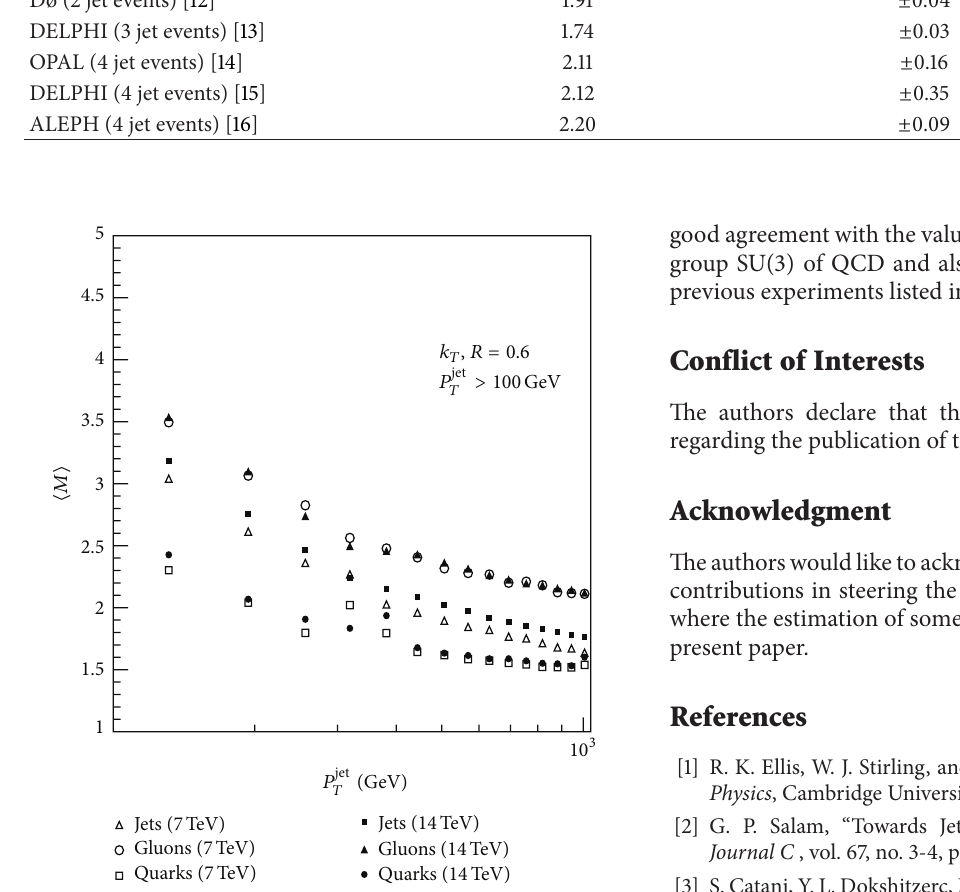
Figure 8: Average subjet multiplicity ⟨𝑀⟩ as a function of jet 𝑃 𝑇 in the pseudorapidity range of |𝜂| < 2 at √𝑠 = 7 TeV and √𝑠 = 14 TeV for 𝑘 𝑇